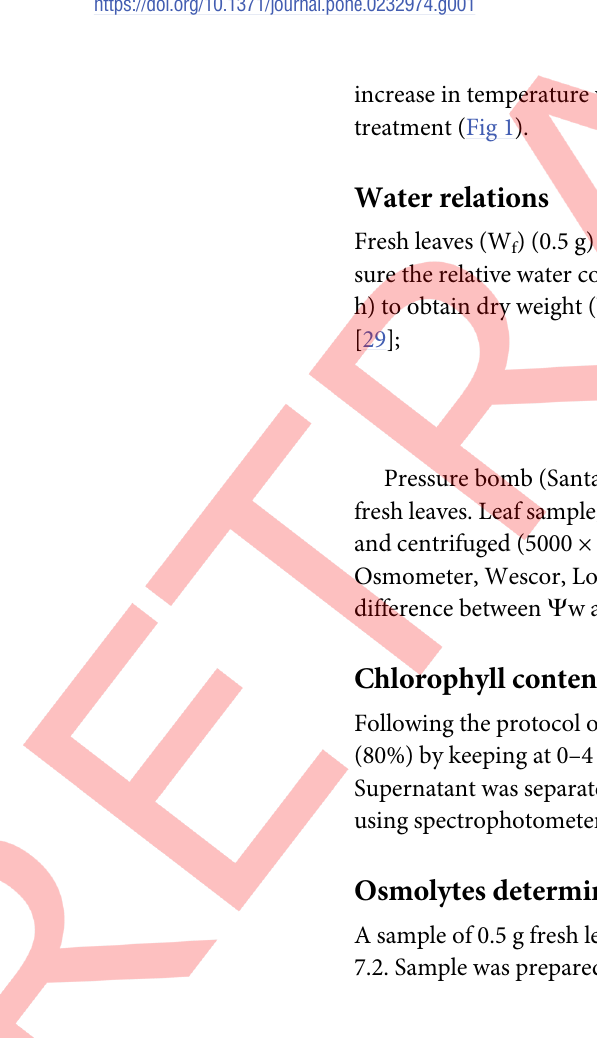
Fig 1. Mean daily temperature of normal and heat stressed treatment for 20 days starting from BBCH 60 growth stage of wheat.